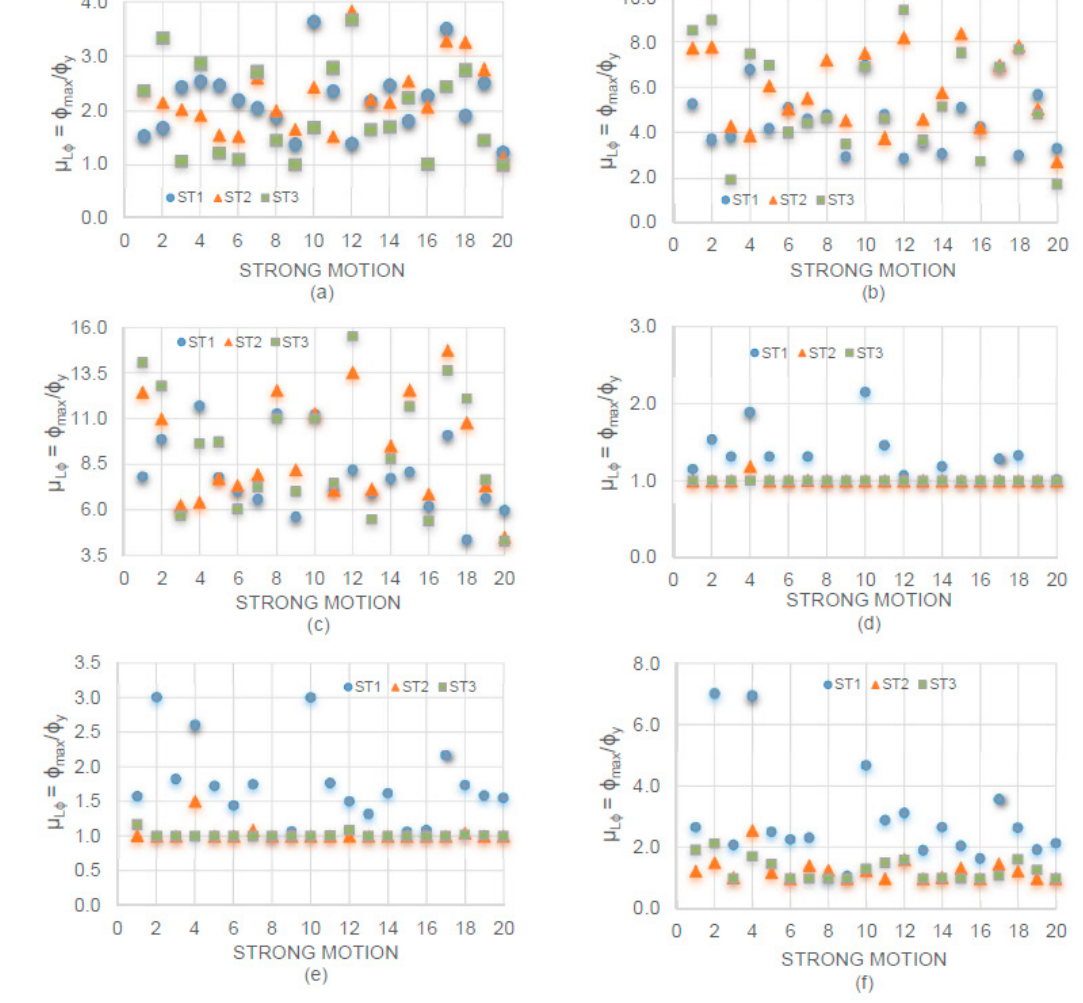
Figure 3. Bending local ductility ( µ L φ ), EW direction, 3-level building; beams: ( a ) S a = 0.4 g, ( b ) S a = 0.8 g, ( c ) S a = 1.2 g; columns: ( d ) S a = 0.4 g, ( e ) S a = 0.8 g, ( f ) S a = 1.2 g.